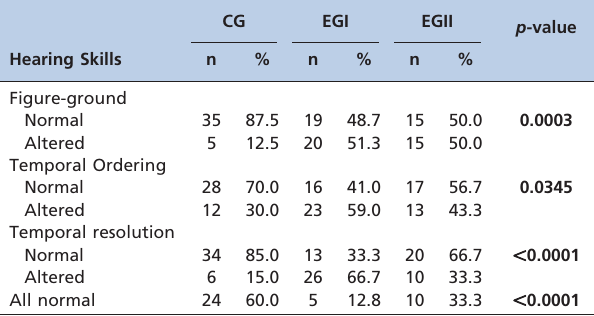
n - number of subjects; % - percent. The p -value was calculated by the chi- squared test.